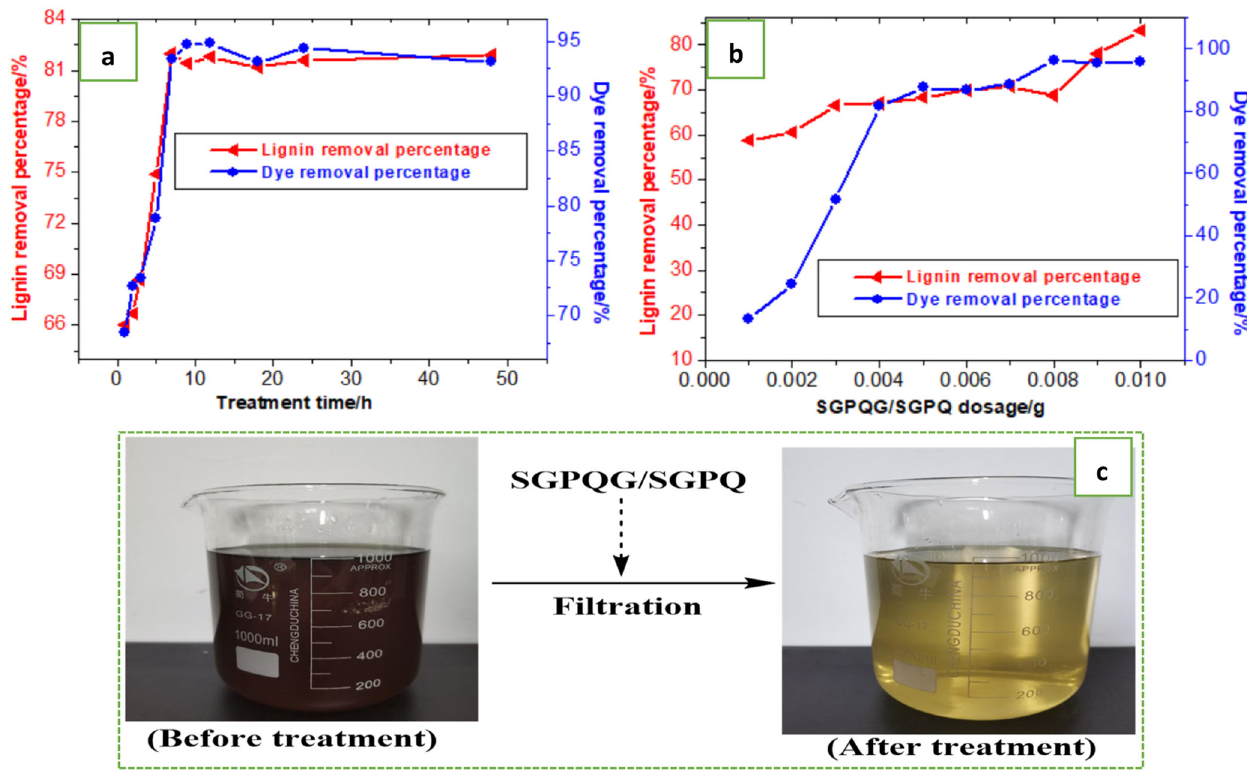
Fig. 9 Application of SGPQG/SGPQ in puri fi cation of complex wastewater and real papermaking wastewater. a Effects of different time on SGPQG/SGPQ treatment with the complex wastewater. b Effects of different dosages of SGPQG/SGPQ materials on treatment of the complex wastewater. ( c ) Application results of SGPQG/SGPQ materials in treatment of the real papermaking